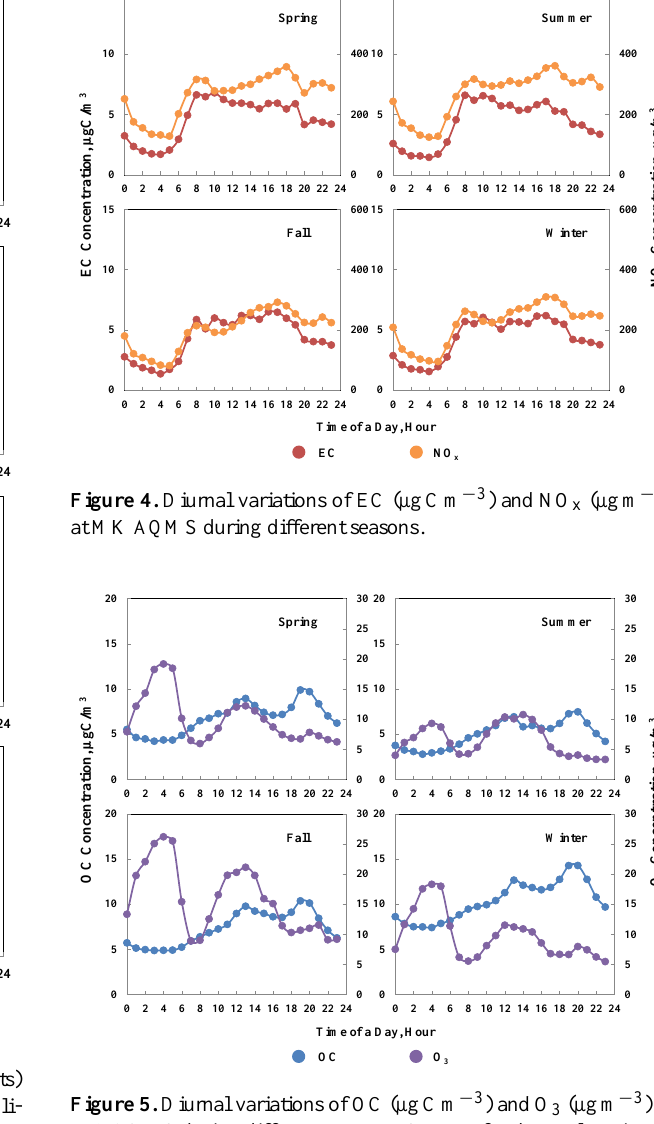
Figure 6 . Monthly average vehicle-related PM 2.5 concentrations estimated by (OM vehicle +EC) and the relative contributions to the monthly average PM 2.5 mass at MK AQMS during May 2011–April 2012. (Note: PM 2.5 mass concentrations were measured by a Tapered Element Oscillating Microbalance (TEOM 1400AB) on an hourly basis.)